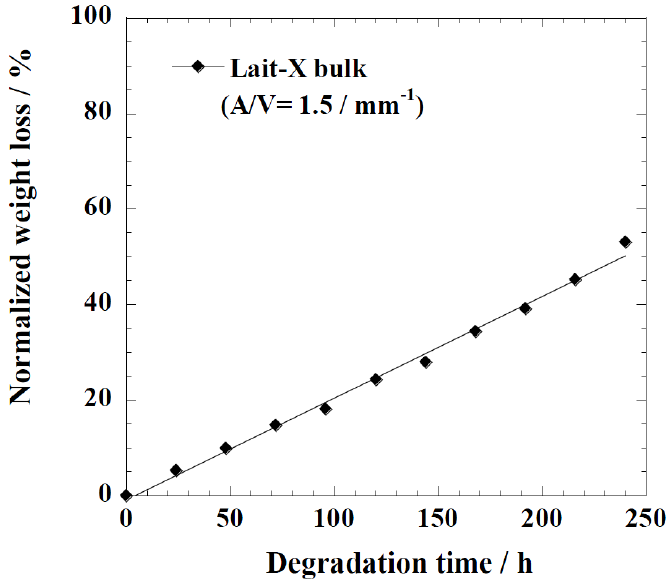
Figure 5. Normalized weight loss of Lait-X bulk. The solid line was calculated by linear regression.